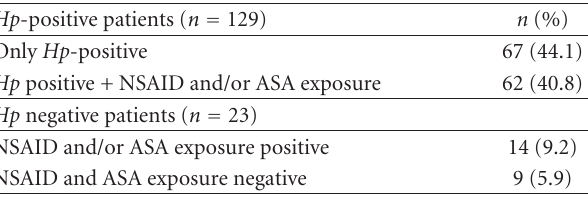
Table 3: Pathogenesis of ulcer in the duodenal ulcer group ( n =